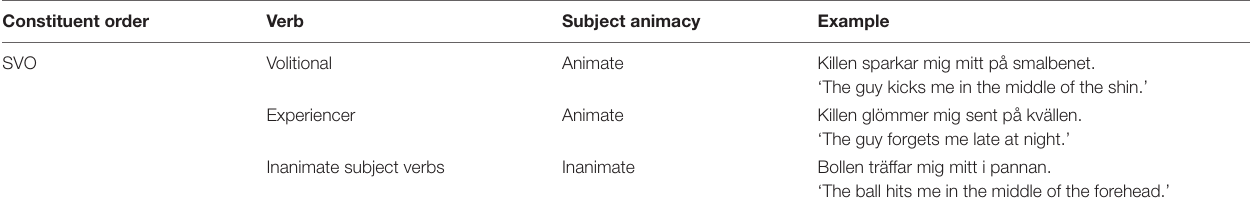
TABLE 3 | Example sentence stimuli of the filler sentences used in the self-paced reading experiment. Constituent